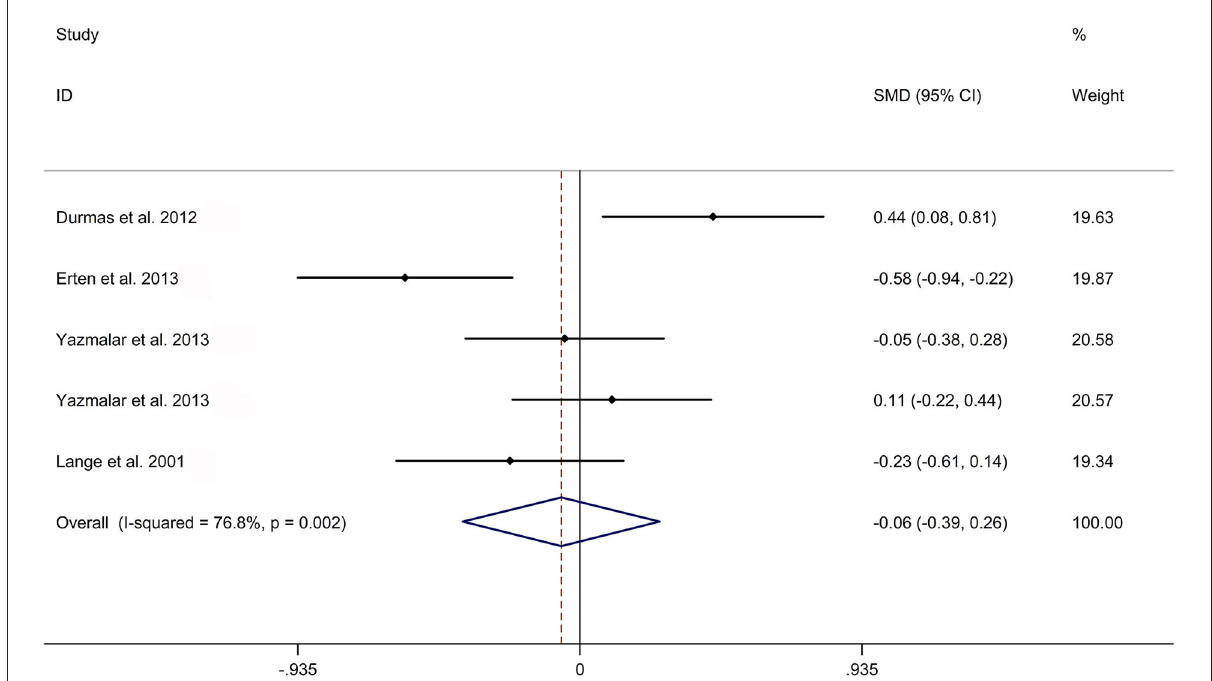
FIGURE7 Forest plot regarding comparison in peripheral calcium levels between AS and HC. AS, ankylosing spondylitis; HC, healthy